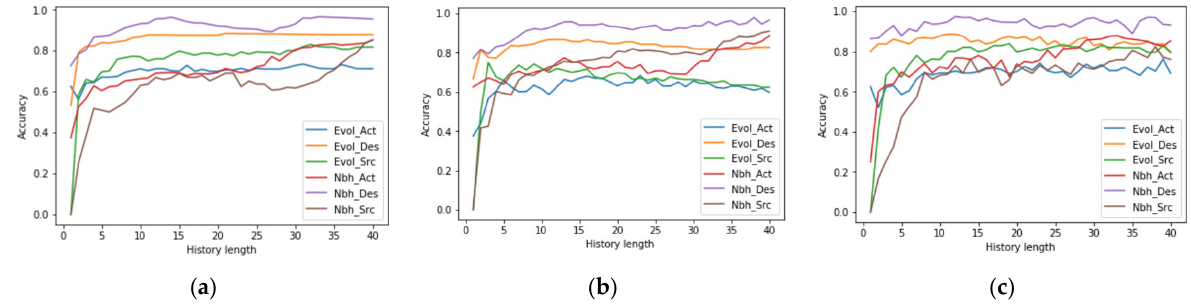
Figure 8. Sequence length evaluation based on APT ‐ M ‐ 2. ( a ) CCR. ( b ) TE. ( c ) Proposed.